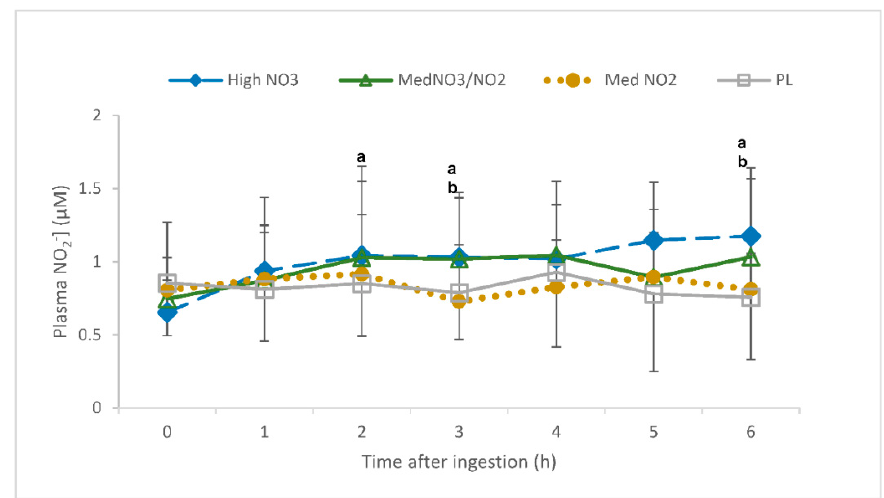
Figure 2. Plasma nitrite concentration ([NO 2 − ]) (uM) over a 6-h period following the ingestion of placebo (PL); high nitrate, low nitrite (HL); low nitrate, medium nitrite (LM); and medium nitrate and medium nitrite (MM) beverages. a Significant difference between HL and PL ( p < 0.05). b Significant difference between HL and LM ( p < 0.05).